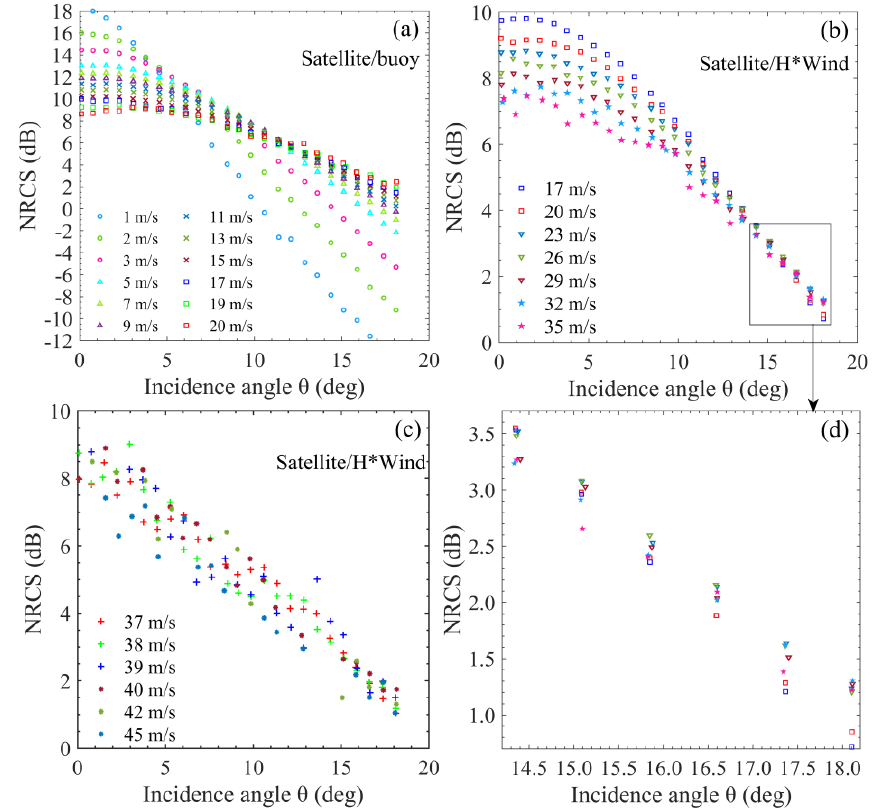
Figure 12. Bin-averaged NRCS measurements as a function of incidence angle for different wind speeds: ( a ) The satellite/buoy data, and ( b , c ) the satellite/H*Wind data. ( d ) Enlarged view of the black frame in ( b ). Symbol types and colors indicate different wind speeds.